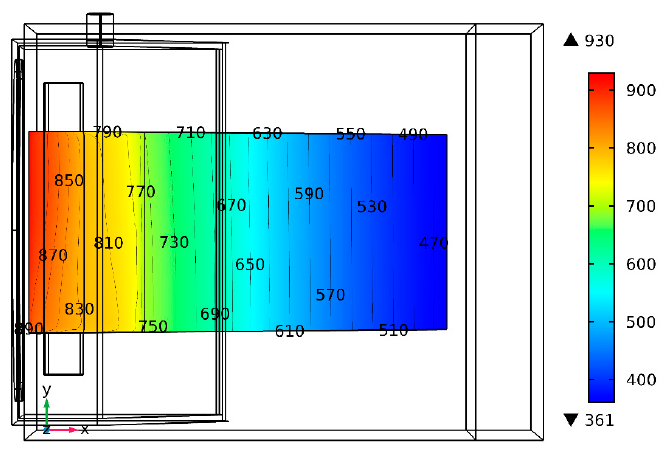
Figure 9. Temperature pattern within the strip (°C).